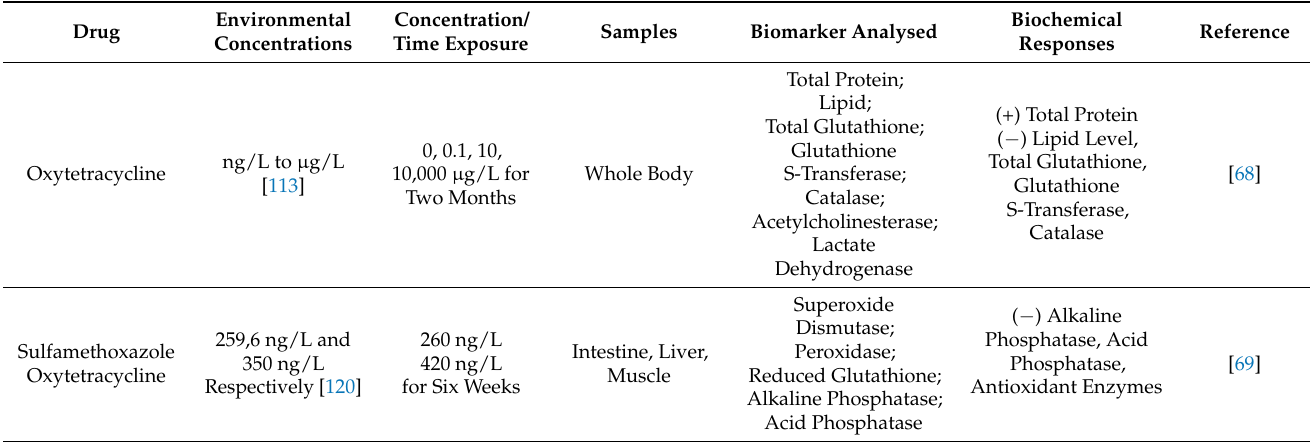
Figure 1. Schematic representation of the effects of antibiotic drugs on the biochemical responses of D. rerio adults. The arrow pointing up indicates “up-regulation” while the arrow pointing down indicates “down-regulation”. Table 1. Biochemical responses in zebrafish exposed to antibiotic and anthelmintics